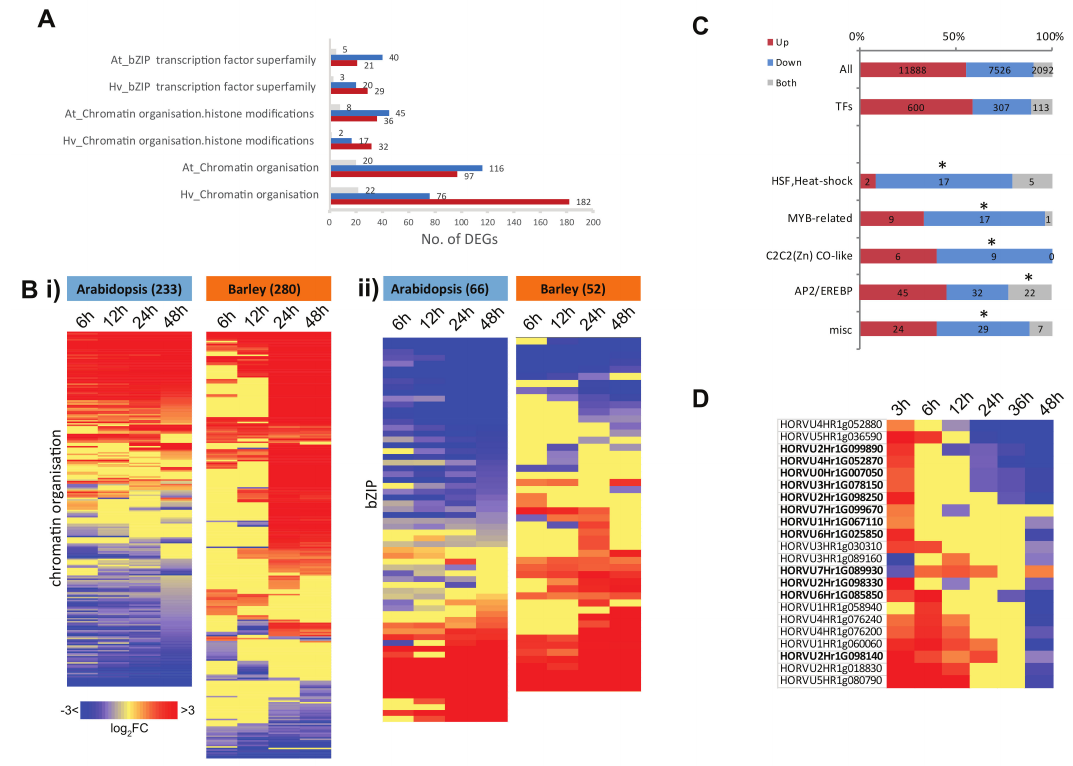
Expression of genes encoding DNA / RNA binding functions during